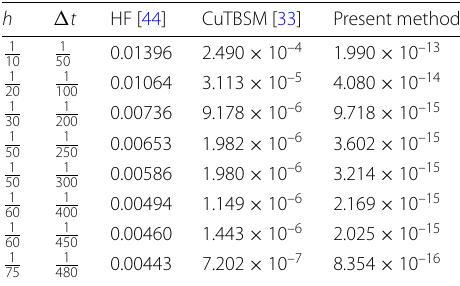
Table 3 Error norm L ∞ at t = 0.4, 0 ≤ z ≤ 1 and α = 1.7 for Example 1